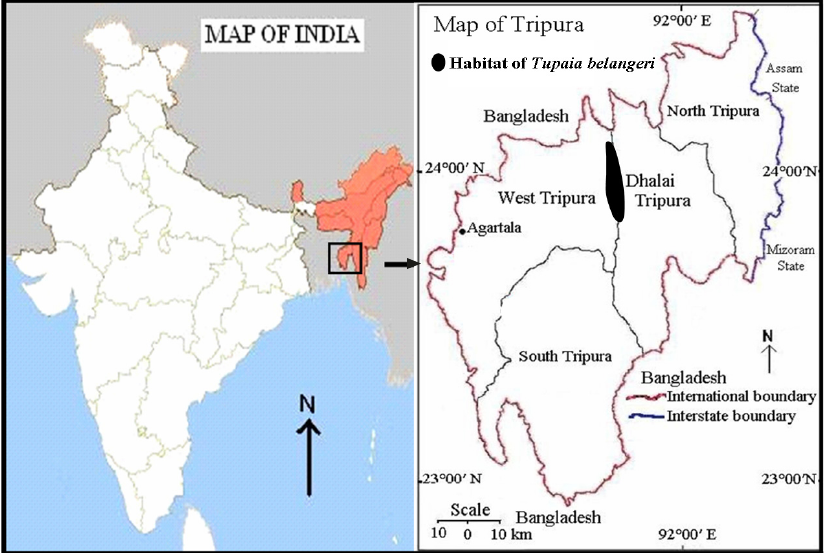
Figure 1. The location of the habitat of Northern Tree Shrew recorded in Atharamura Hill Ranges, Tripura.